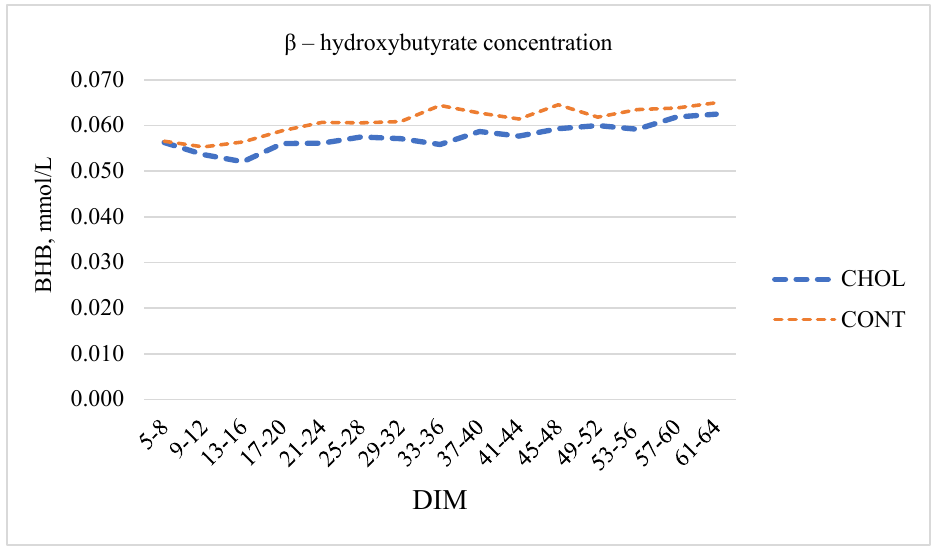
Figure 1. Changes in β –hydroxybutyrate concentration in milk of the choline and control groups at different DIM intervals.